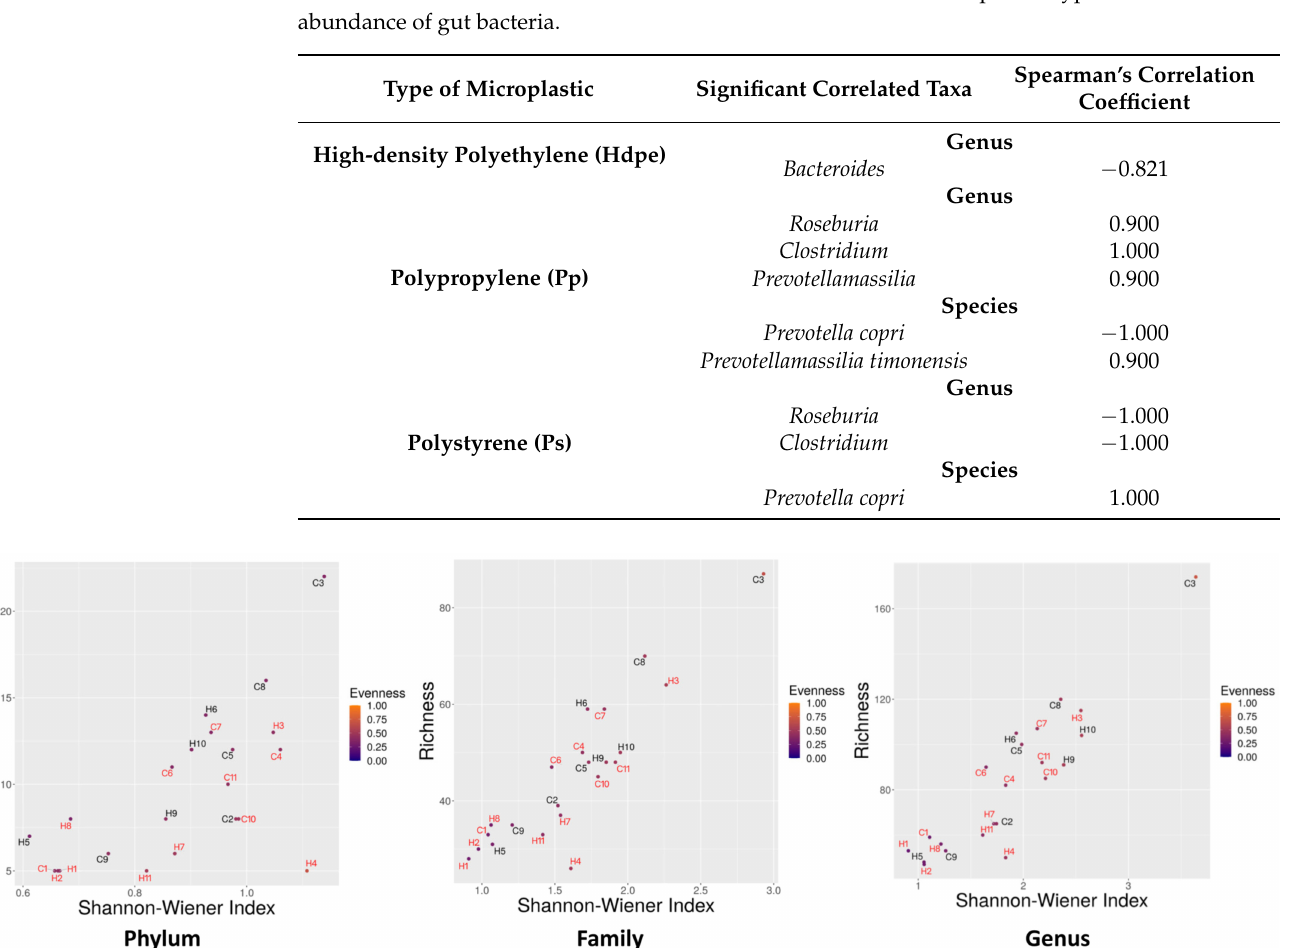
Figure 2. Gut microbiota richness, diversity, and evenness value of Indonesian coastal and high- land populations at the phylum, family, and genus level. Abbreviations of samples: C—Coastal, H—Highland, sample code in red represents individuals with microplastic contamination, while sample code in black represents individuals without microplastic